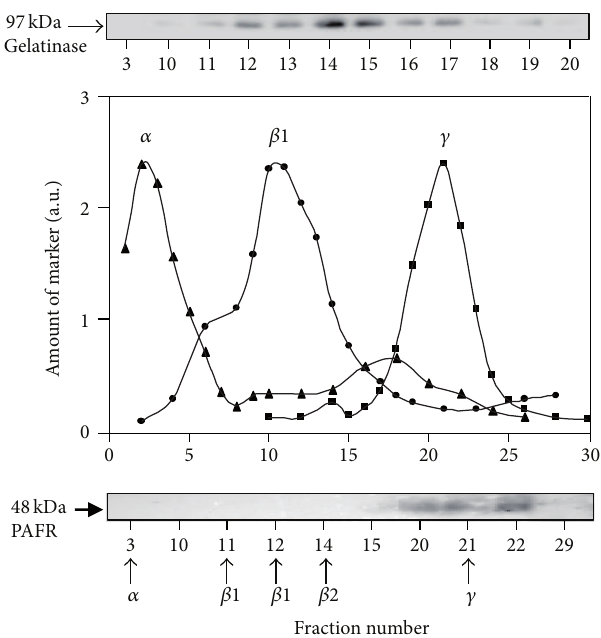
Figure1:SubcellularlocalizationofthePAFRinrestingneutrophils. Neutrophil subcellular organelles from disintegrated cells were fractionated on a three-layer Percoll gradient. Upper panel. The distribution of gelatinase (marker for the 𝛽 -fractions) visualized through immunoblotting. Middle panel: localization of azurophil granules ( 𝛼 -fraction; marker MPO) specific granules ( 𝛽 1-fraction; markers NGAL) and plasma membrane/secretory vesicles ( 𝛾 - fraction; ALP). The markers (MPO = 󳵳 ; NGAL = ∙ ; ALP = ◼ ) are expressed in arbitrary units. Lower panel: proteins from selected fractionswereseparatedbySDS-PAGE,andthelocalizationofPAFR was determined by immunoblotting with a specific antibody against